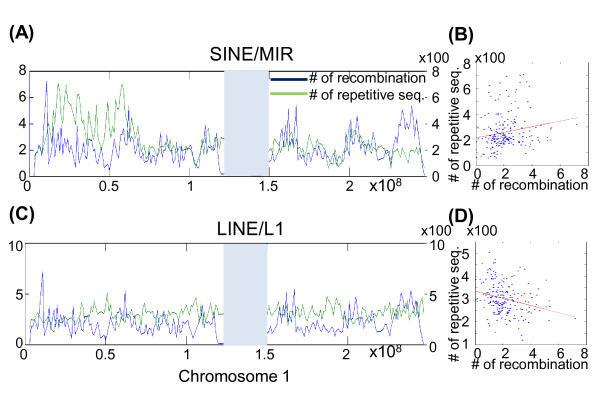
Correlation between the number of sex-averaged recombination sites and SINE/MIR (A, B) or LINE/L1 (C, D) repetitive sequences elements. The distribution of the number of sex-averaged recombination sites (blue) and repetitive sequences elements (green) on chromosome 1 was calculated using a window width set to 1 Mb (A, C). The scatter plot shows the number of sex-averaged recombination sites and repetitive sequences on chromosome 1 (B, D). Regression lines are marked in red. The chromosomal regions without any SNP site in the Affymetrix Genome-Wide Human SNP 6.0 arrays are marked as gray blocks.